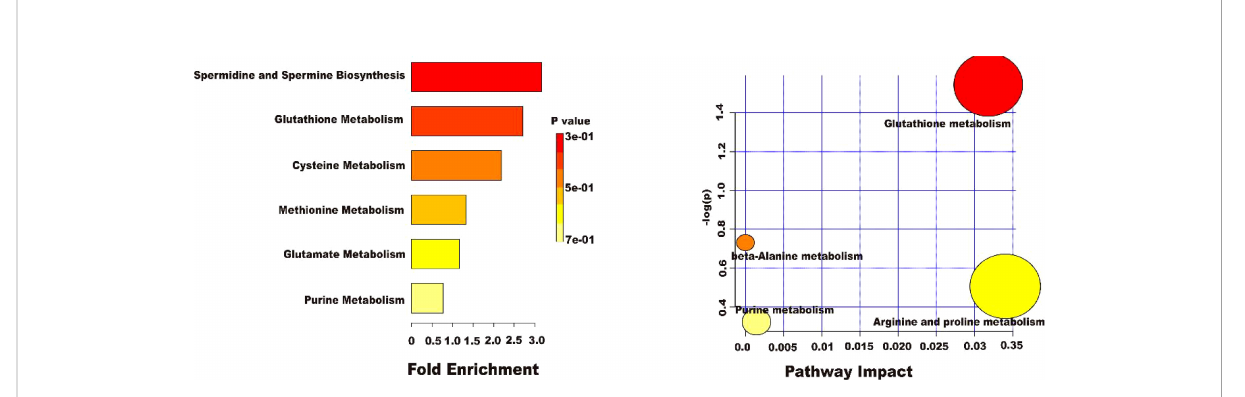
FIGURE 10 Results of ploidy enrichment and pathway analysis of potential metabolites in